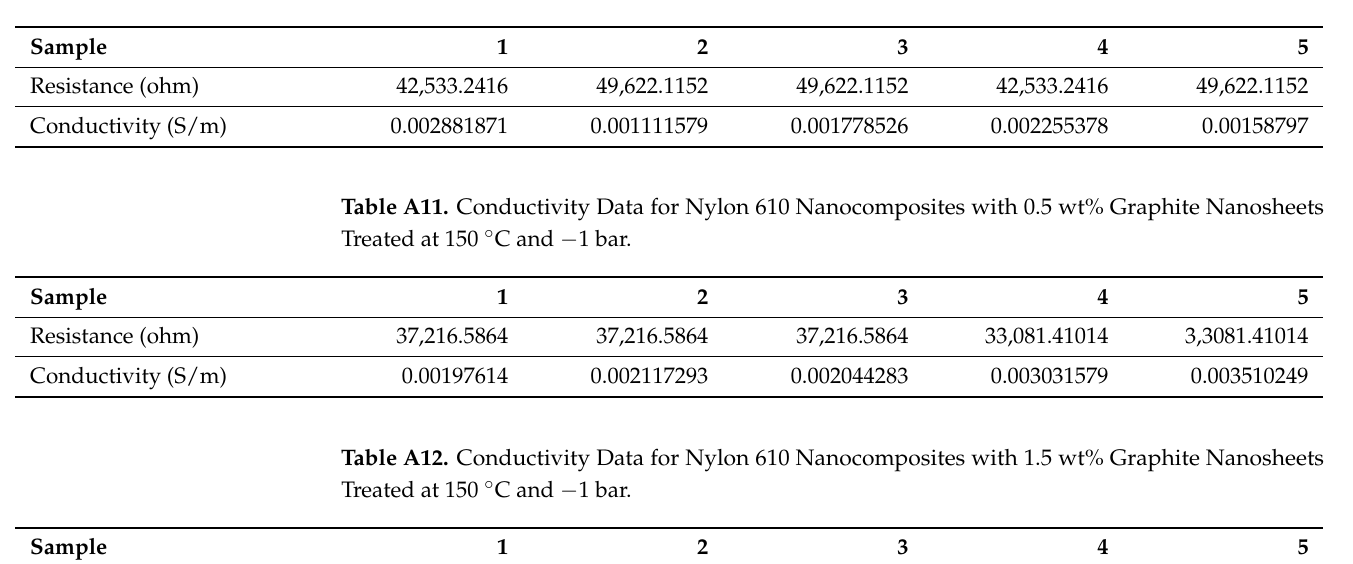
Table A10. Conductivity Data for Nylon 610 Nanocomposites with 4.5 wt% Graphite Nanosheets Treated at 175 ◦ C and − 1 bar.